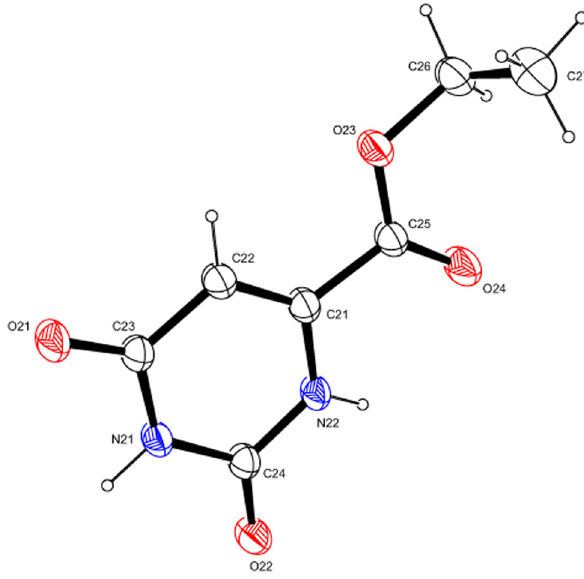
Figure 3: Crystal structure of compound 4